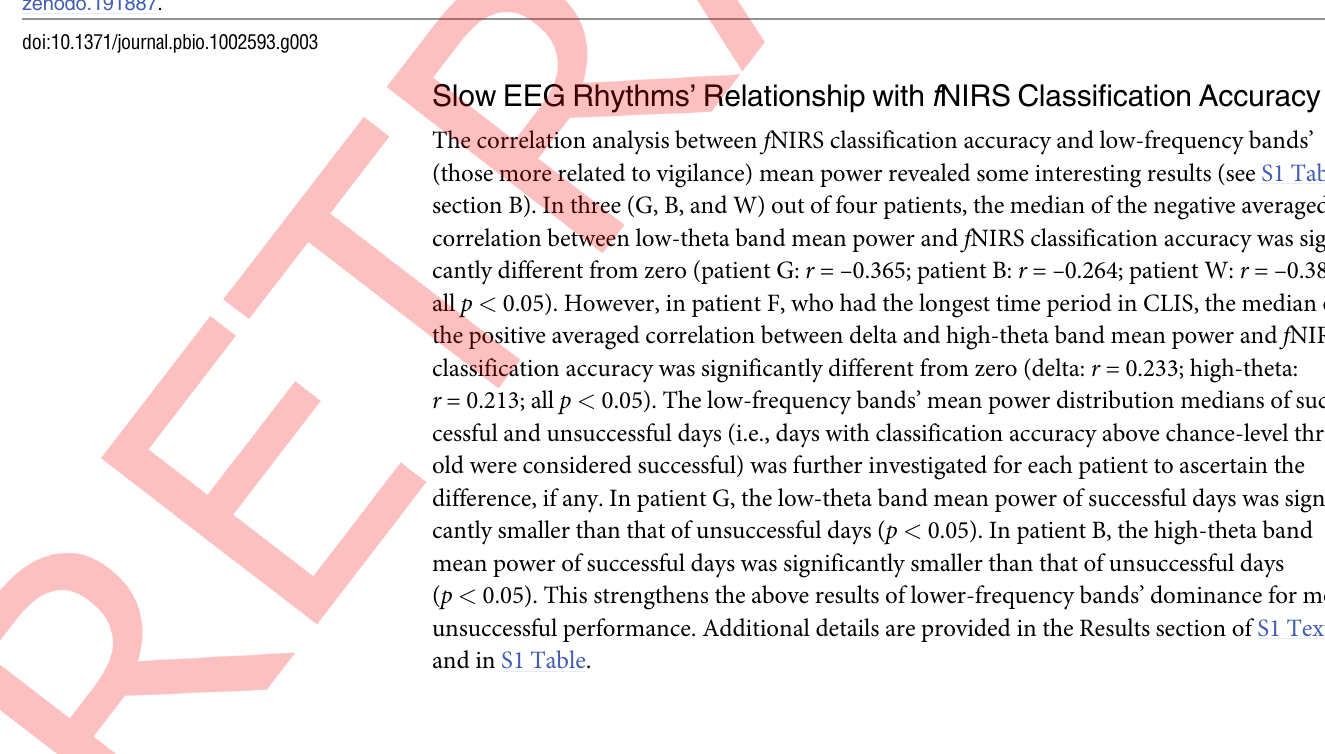
Fig 3. Classification accuracyof Patient G. The descriptionof this figure is the same as describedin Fig 2. Fig 3 data is locatedat https://doi.org/10.5281/